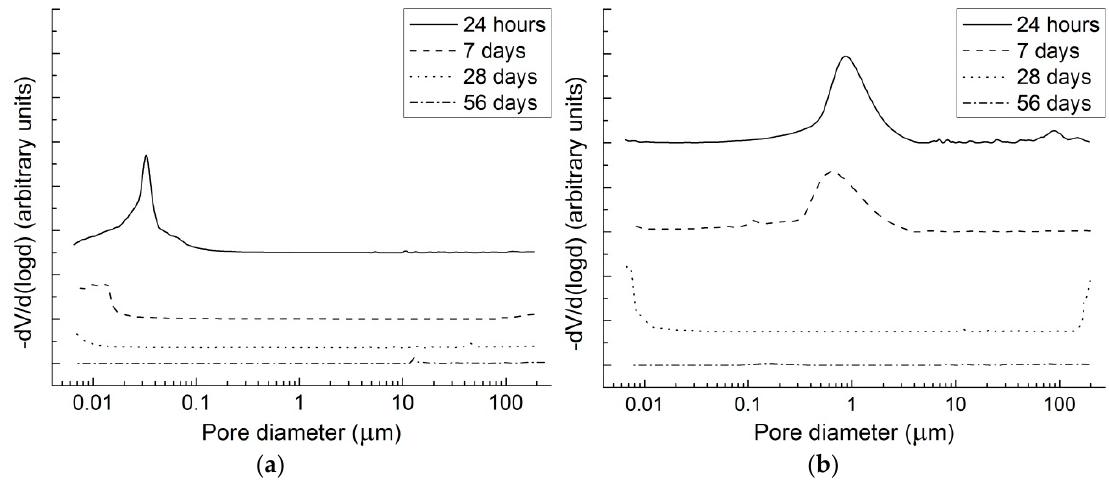
Figure 5. MIP curves showing the effect of SRA on pore structure development: ( a ) pure AAS paste; ( b ) AAS paste with 1% of SRA.